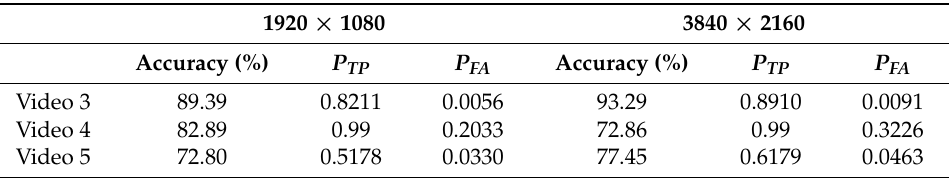
Table 10. HMM detection results at 1080p and 4K resolutions.